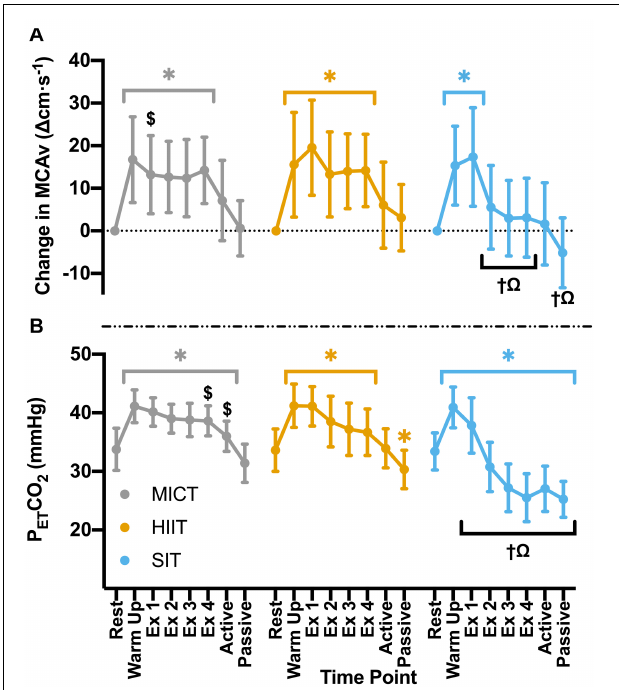
FIGURE 3 | (A) MCAv was determined continuously by transcranial doppler ultrasound (TCD) and presented as change in MCAv from rest in each protocol for each participant. (B) P ET CO 2 was determined by measurement of breath-by-breath respiratory gas exchange and ventilation. Data were averaged for 1 min during seated rest (Rest); over 30 s during the final minute of four 4 min high intensity (85% HR max ) interval bouts (HIIT; Ex 1 – 4); across the duration of four 30 s supramaximal (200% W max ) sprint intervals (SIT; Ex 1 – 4), and over a 30 s period, 15 s into the recovery following each bout in both interval protocols (Reco 1 – 4). Data are presented as mean ± SD ( n = 24). Significance (analyzed by linear mixed model, p < 0.05) between time points is denoted by ∗ for differences from resting values; (cid:99) for differences between interval (ex) and recovery (reco). Significant differences between protocols are denoted by (cid:127)